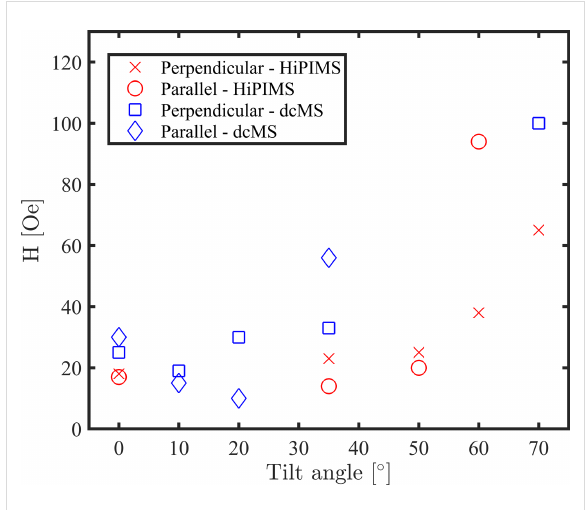
Figure 6: The H c and H k (for samples with uniaxial anisotropy) of our nickel films measured using MOKE with the magnetic field applied parallel and perpendicular to the sputtered flux direction, respectively. Uniaxial anisotropy is presented in HiPIMS samples of 60° and 70°, and in dcMS of 35° and 70°. The H k of films deposited at 70° was out of the measurement